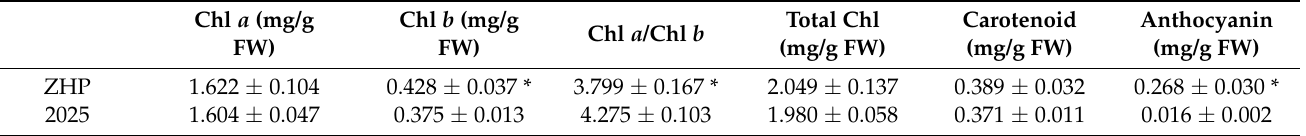
Table 1. Chl, carotenoid and anthocyanin contents in leaves between ‘L2025’ and